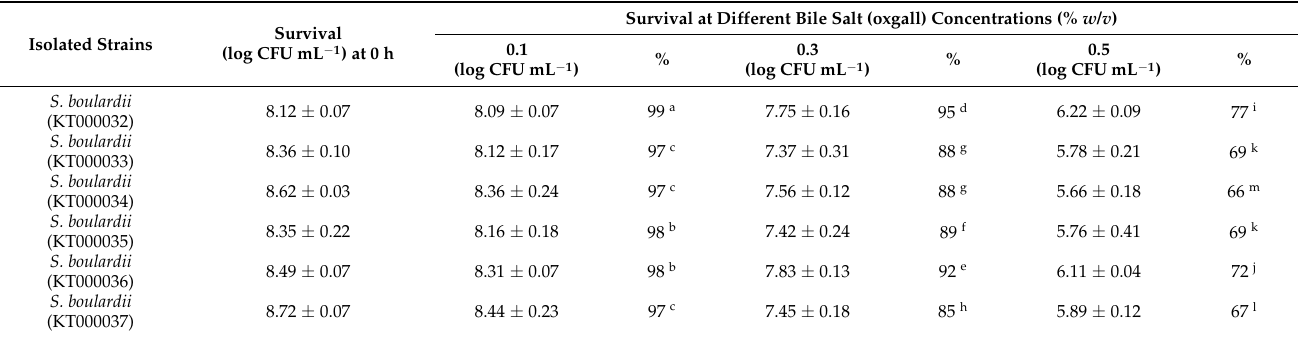
Table 2. Bile tolerance of six Saccharomyces boulardii strains isolated from frozen idli batter. Isolated Strains